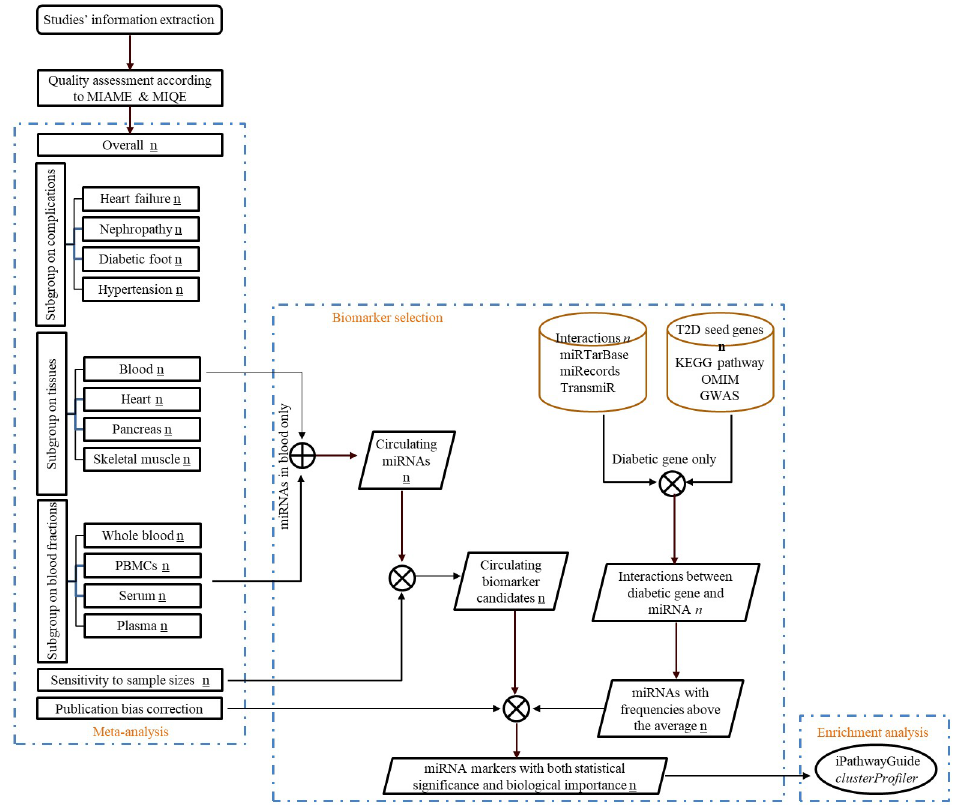
Fig 4. Flow diagram showing the overall design of this study and stepwise selection of circulating microRNA biomarkers. Statistical significant circulating microRNAs will be first identified by meta-analysis, which is filtering by sensitivity analysis to find the robust one. Experiment validated microRNA targets are used to further screen biologically significant microRNA markers according to well-established T2D genes. Number with underline, in italic and in bold indicates the number of statistically significant microRNAs, the number of interactions between microRNAs and targets, and the number of seed genes of T2D, respectivily. � , the union of microRNAs. ⦻ , the intersection of